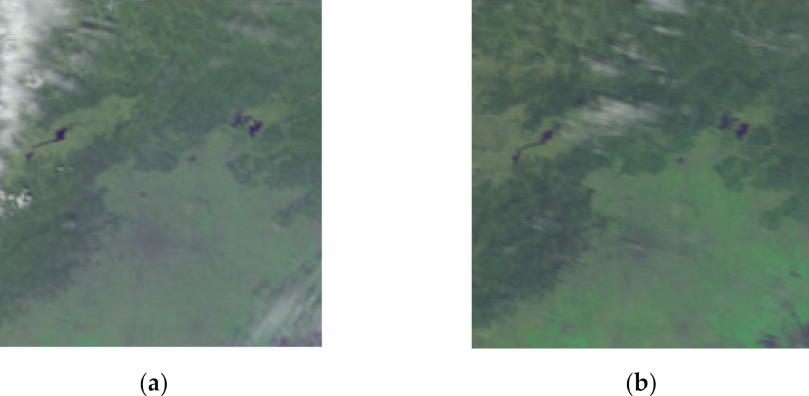
Figure 2. Corrected remote sensing images. Here, ( a , b ) are two remote sensing images with different haze levels on different dates. The corrected results show that the size and range of the images are the